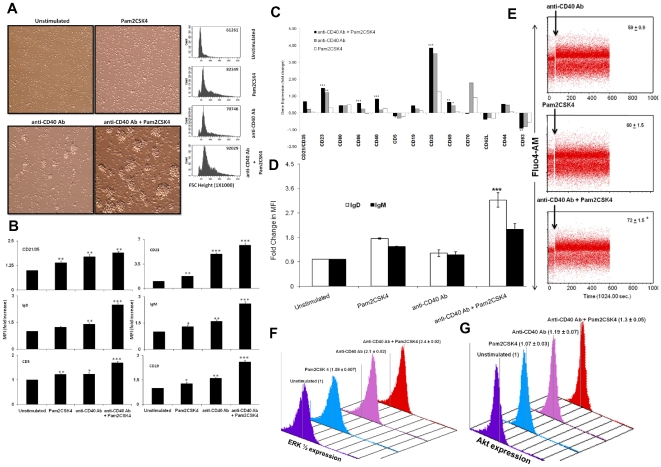
Signaling through CD40 bolsters the activation phenotype of the TLR-2 stimulated RB cells.(A) Signaling was delivered in RB cells with Pam2CSK4 and anti-CD40 Ab for 16 h and formation of B cell blasts (left panel) was seen microscopically by bright field images (20×1.6× magnification). Shown here are the representative images from 5–6 fields from each culture well. Change in forward scatter was assessed through flow cytometry (right panel). X-axis depicts increase in size of B cells (forward scatter, FSC; 1×1000) on a linear scale. The FSC values in inset are normalized with isotype-matched control. (B) Stimulated B cells were stained for the expression of B cell activation markers CD21/35, CD23, CD19, IgM, IgD and CD5. Fold change in mean fluorescence intensity (MFI) was calculated with respect to unstimulated controls. Data are pooled from 3–6 independent experiments and expressed as average fold change (mean ± SEM) in the expression with respect to unstimulated controls. (C) Modulation in the expression of genes involved in B cell activation as analysed through microarray. Bars indicate fold change in geometric mean of the gene expression. Data is representative of one of the biological replicate experiments. (D) Surface expression of IgD and IgM on stimulated RB cells. Bars indicate average fold change (mean ± SEM) in the expression of IgD and IgM. Data are pooled from 3–6 independent experiments and expressed as average fold change (mean ± SEM) in the expression with respect to unstimulated controls. (E) TLR2.CD40 stimulated RB cells were loaded with Fluo-4 AM dye and calcium flux was measured over a period of 10 minutes. Shown here are representative dot plots from 3 independent experiments. Values in the inset are the averaged geometric mean of MFI of Fluo-4 AM from three experiments with SEM. (F,G) TLR2.CD40 stimulated cells were stained for intracellular phosphorylated ERK1/2 and Akt and analysed by flow cytometry. Shown here are plots from one of the three independent experiments and values represent mean ± SEM of fold change in expression with respect to unstimulated controls. . ‘*’, ‘**’, ‘***’ indicates p<0.05, p<0.01, p<0.001 respectively.